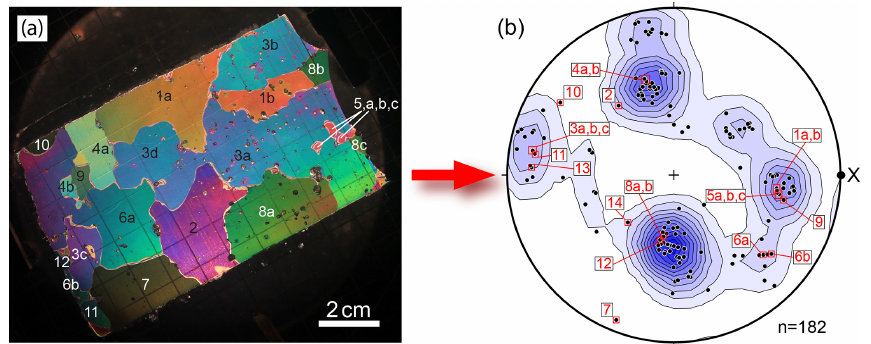
Figure 2. (a) A thin section under cross-polarized light from sample SG6-B collected in 2016. Grains are labeled based on their c -axis orientations, measured using a universal Rigsby stage. Grains with the same orientation were tentatively marked as the same grain as indicated by lettering. Color gradients across some larger grains are a result of inconsistent thin-section thickness; (b) Associated c -axis plot compiled from eight thin sections from the sample SG6-B. This plot contains orientations of all grains measured and is contoured using the Kamb method (Kamb, 1959). When possible duplicates within the same section are removed; the pattern maintains its multimaxima nature but is weaker (not shown). Numbered data points correspond to numbered grains in (a) . In order to obtain 100 individual crystal measurements, 5–15 thin sections had to be made for each sample, depending on the overall grain size in the individual sample. The projection is plotted such that the pole to foliation is vertical and x is the flow direction. The data in this figure are not included in the combined Fig. 8 because, after U-stage work, there was not enough of this sample to use for EBSD, and thus there are no a -axis data